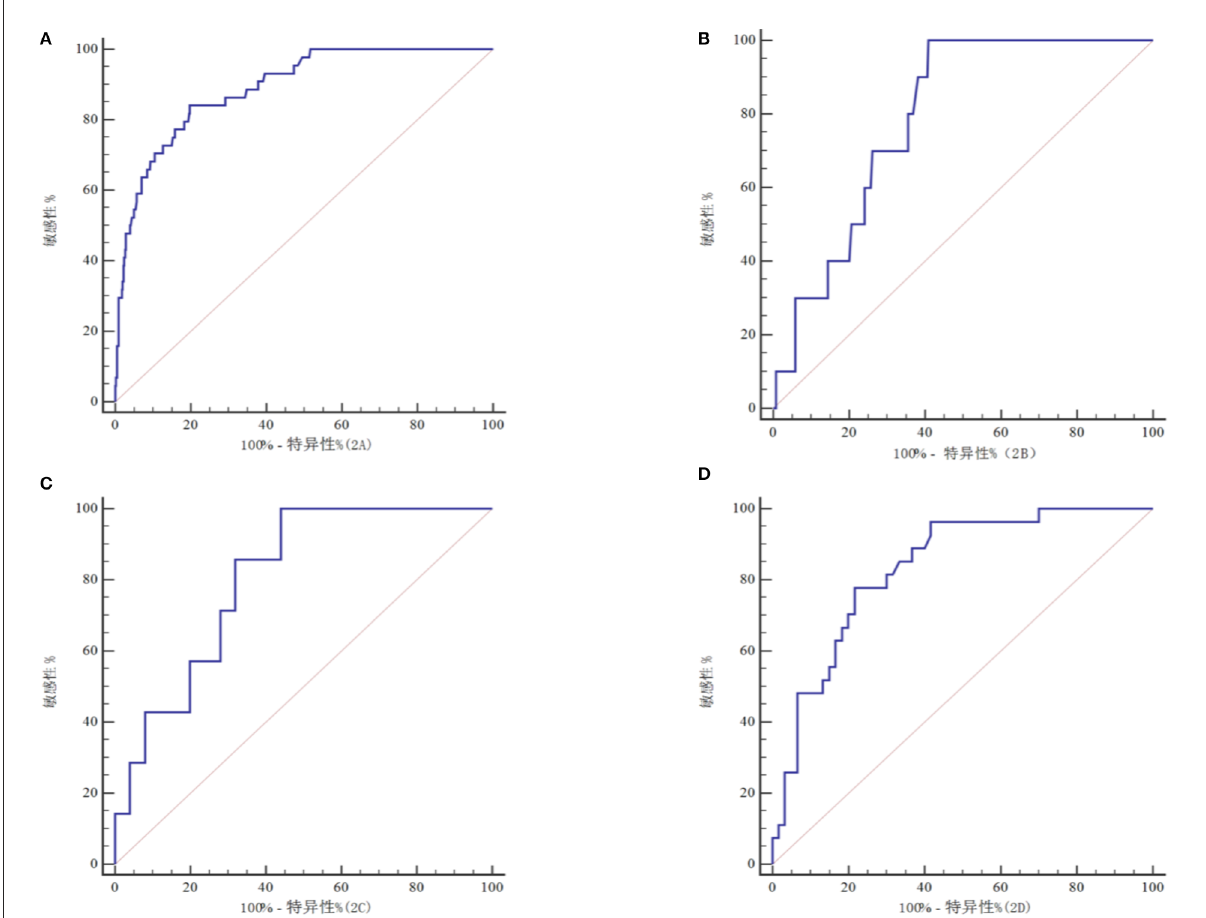
FIGURE2 ROC curve of to predict prognosis in all craniocerebral trauma patients (A) , in mild craniocerebral trauma patients (B) , in moderate craniocerebral trauma patients (C) , in severe craniocerebral trauma patients (D) .